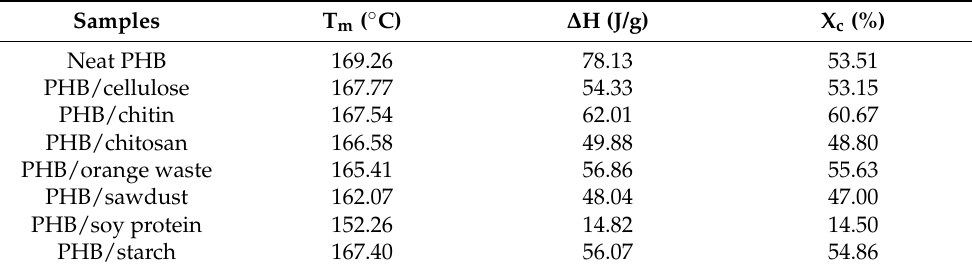
Table 1. Thermal properties of neat PHB and its biocomposites. Single measurements were carried out for each